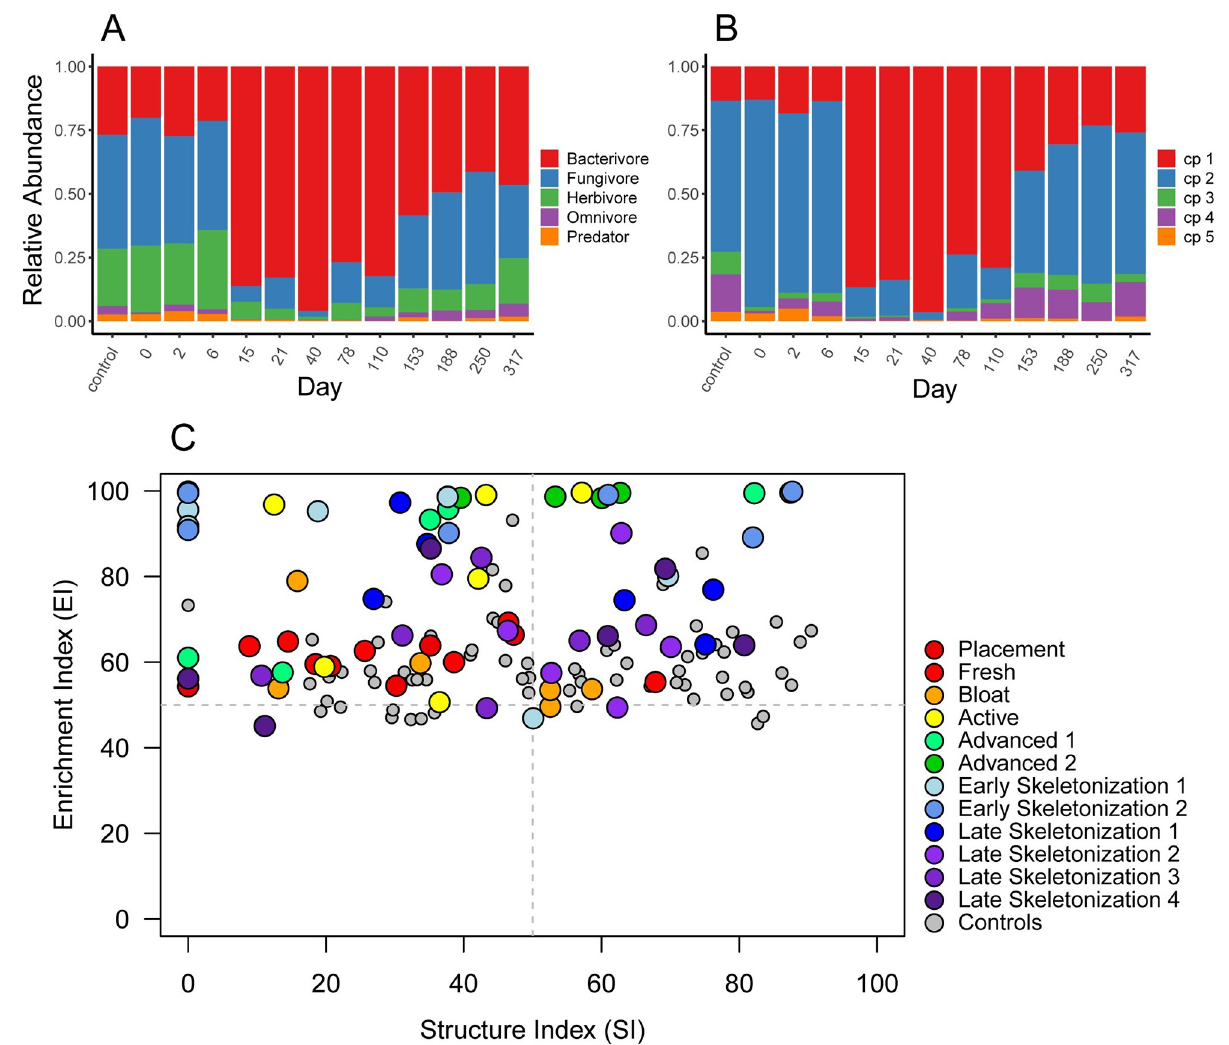
Fig 3. Temporal changes in nematode community composition and functional diversity in core (0–30 cm) soils. Relative abundances of (A) trophic groups, (B) cp-classes, and (C) functional diversity analysis for core (0–30 cm)